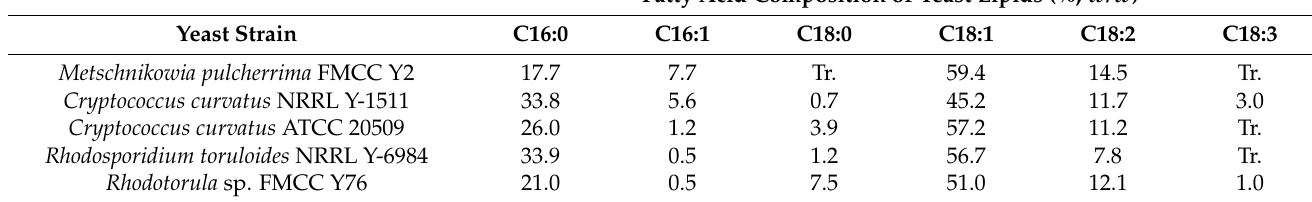
Table 4. Fatty acid composition of the cellular lipids produced by yeast strains cultivated on crude glycerol in shake-flask experiments (Glyc0 ≈ 50 g/L). Time of fermentation for the determination of the fatty acid composition was between 170 and 220 h after inoculation. Culture conditions as in Table 1. Tr.: traces (<0.5%). Fatty Acid Composition of Yeast Lipids (%, w/w ) Yeast Strain